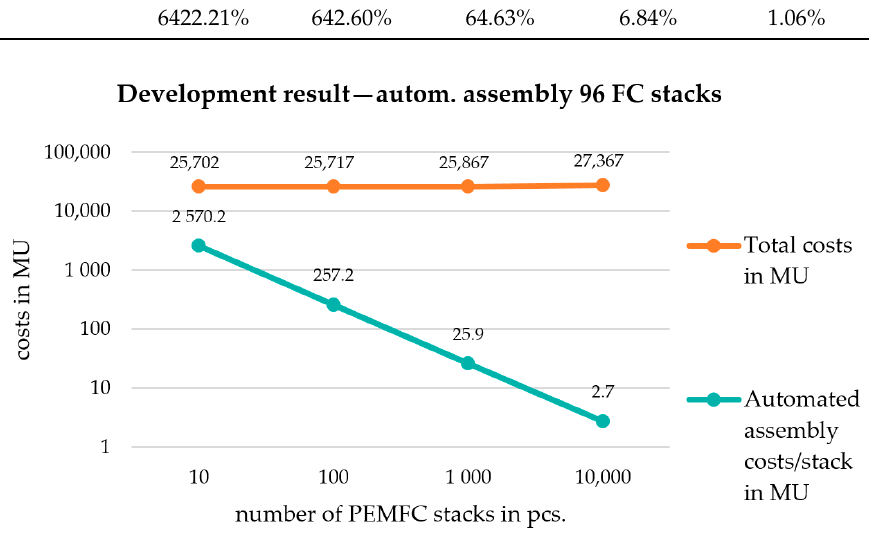
Figure 12. Developed mass manufacturing machine (MMM)—automated assembly of the “modular Figure12. Developedmassmanufacturingmachine(MMM)—automatedassemblyofthe“modularsystem system seven-layer membrane electrode assembly (MEA)”—production time 10 min/stack with one seven-layer membrane electrode assembly (MEA)”—production time 10 min / stack with one operator. operator.